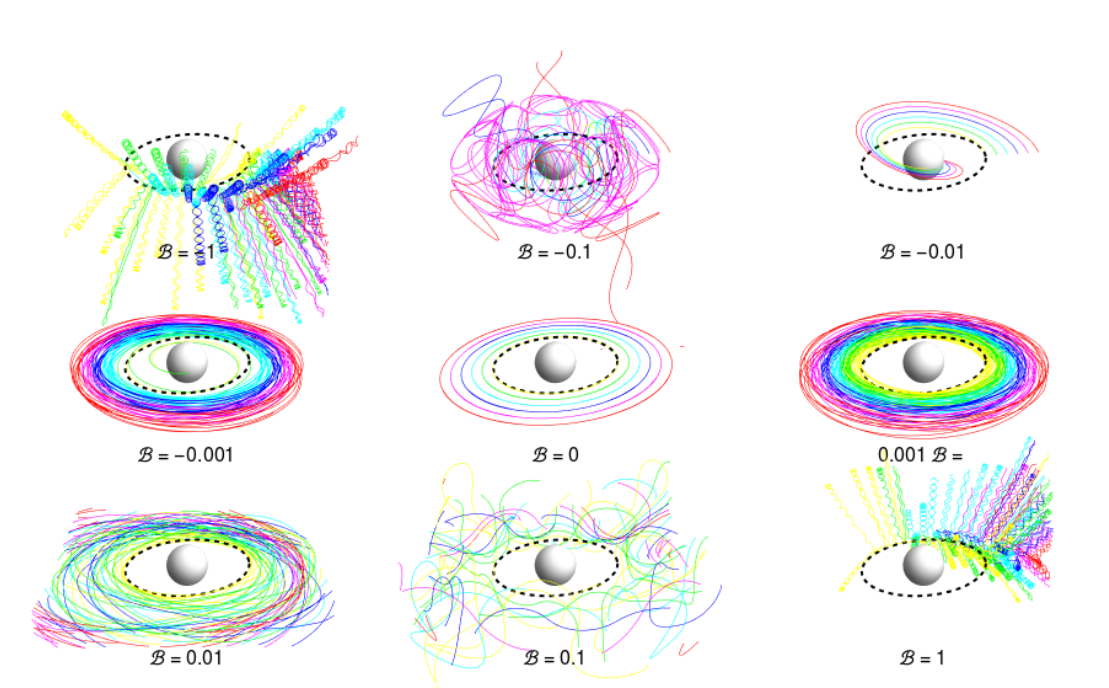
Figure 8. Thin Keplerian accretion disk around Schwarzschild BH in parabolic magnetic field. The disk is located closely to the equatorial plane of the background. The dependence of the fate of the ionized disk on the magnetic parameter is generally in concordance with the case of the uniform and dipole magnetic